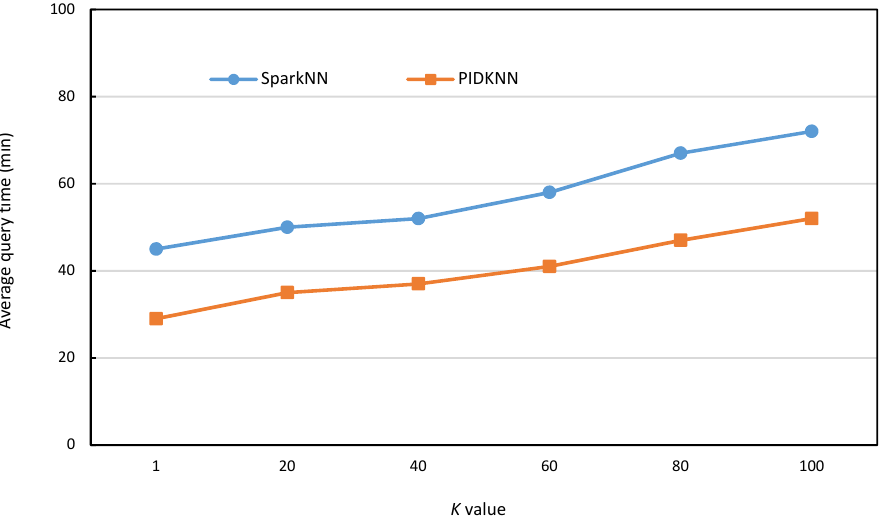
Figure 12. Average query time vs. k value.